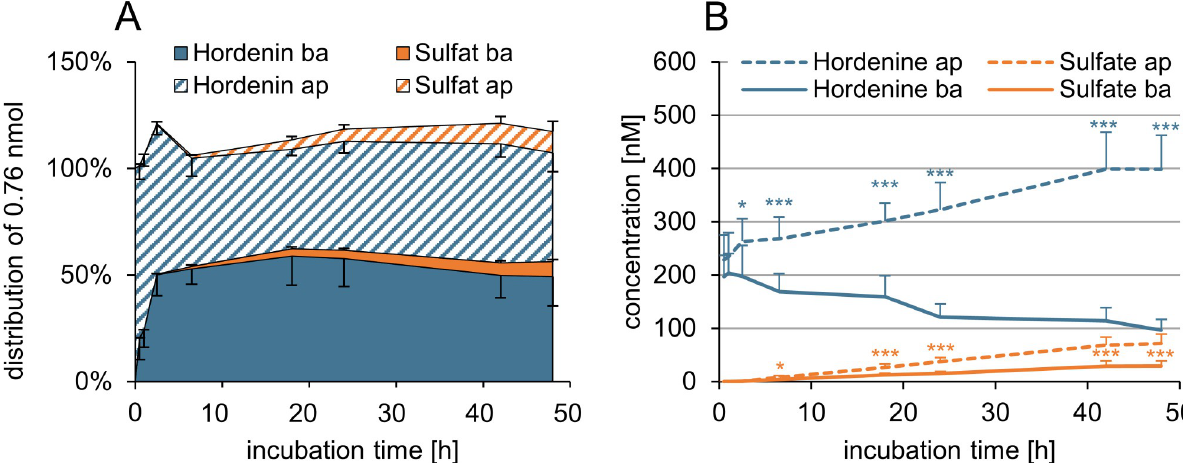
Fig 4. Passive transfer (A) and active transport (B) of hordenine through the Caco-2 monolayer over the course of 48 h. The passive transfer of 1 μ M hordenine from apical (ap) to basolateral (ba) compartment was determined ( n = 3 × 3). Hordenine and hordenine sulfate (abbreviated as sulfate) were quantified using HPLC-MS/MS and normalized to the initial amount (0.76 nmol) on the apical side. For active transport experiments equimolar concentrations of 200 nM hordenine were applied in the apical and basolateral compartment ( n = 3 × 3). Data are presented as means ± standard deviations. Statistically significant differences between concentration in the two compartments are marked by asterisks ( � : p � 0.05; �� : p � 0.01; ��� : p �